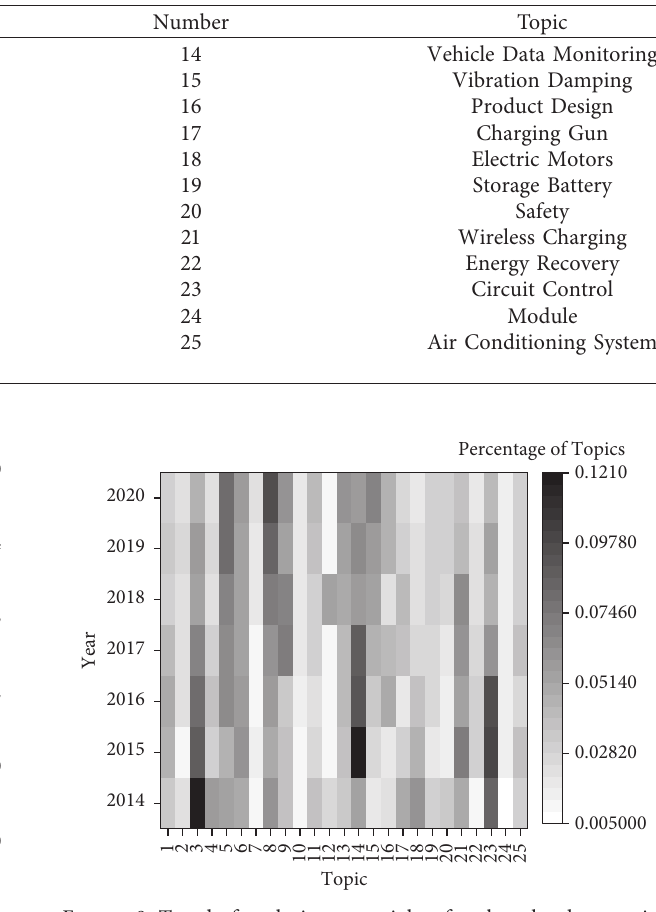
Table 3: New energy vehicle technology topics.